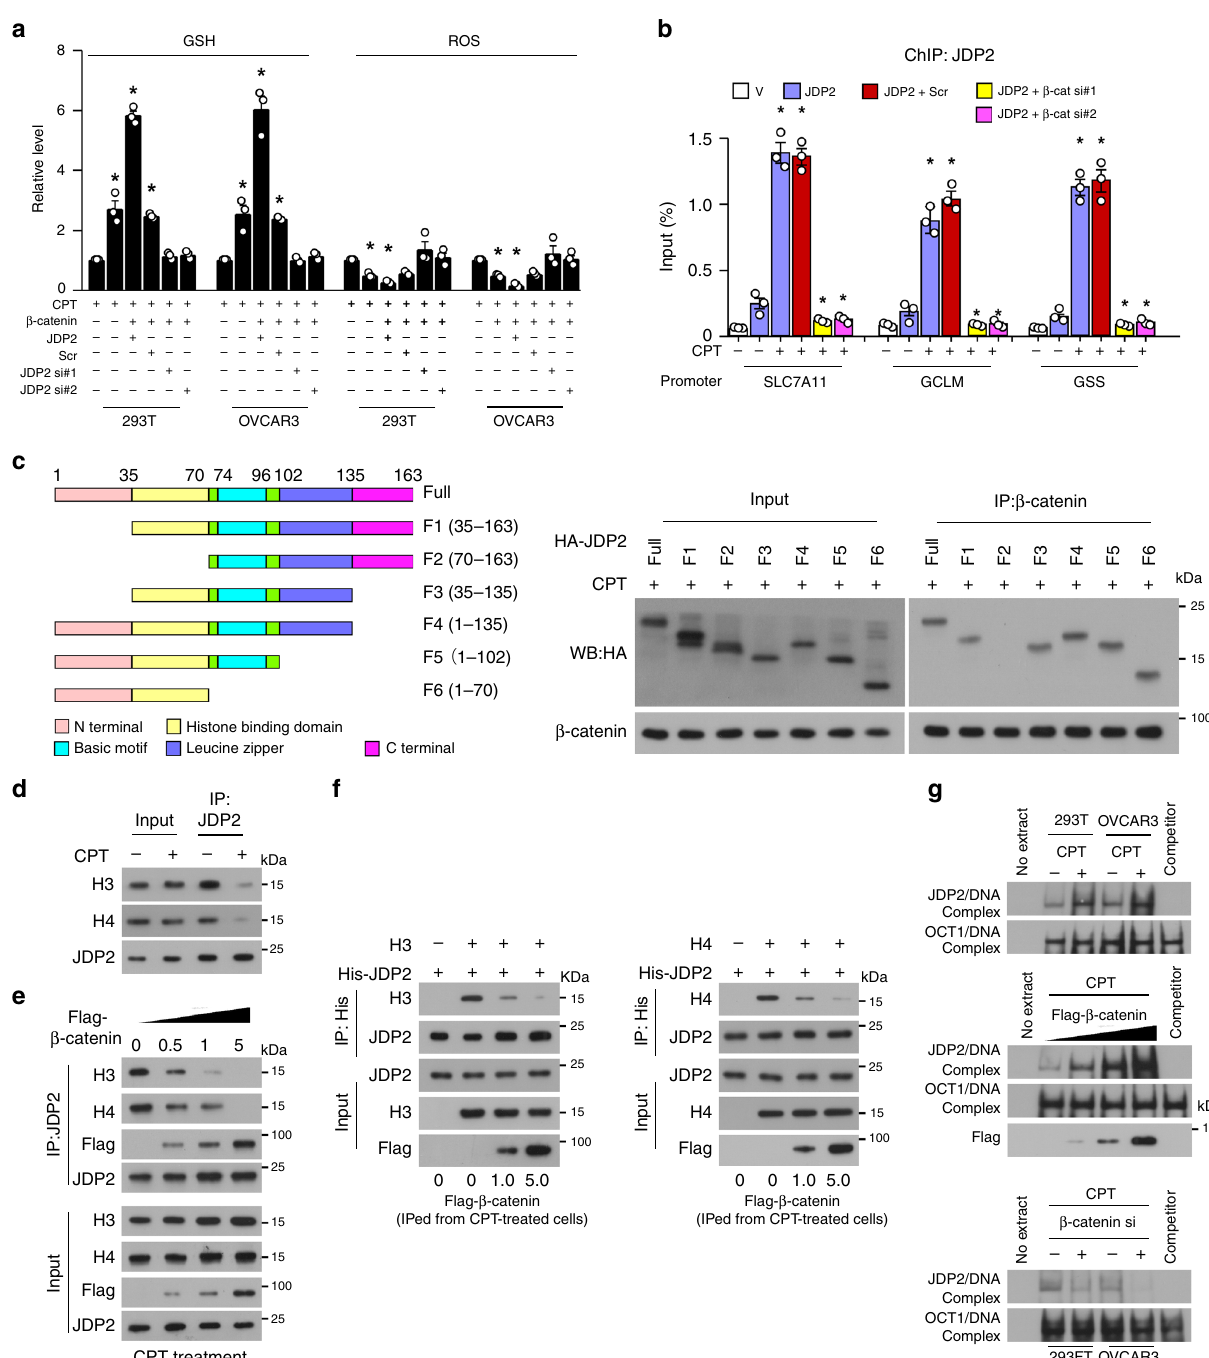
Fig. 4 β -catenin promotes the DNA-binding activity of JDP2 via inhibition of the JDP2/histone interaction. a Relative expression of GSH (left) and ROS (right) were examined in the indicated cells treated with CPT (10 μ M, 4 h). + : treatment, − : untreatment. b ChIP assay analysis of the enrichment of JDP2 on the promoters of SLC7A11 , GCLM , and GSS in the indicated cells treated with or without CPT (10 μ M, 1 h). c Schematic illustration of the wild-type and truncated JDP2 (left); co-IP assays were performed using anti- β -catenin antibody in the CPT (10 μ M, 1 h)-treated cells transfected with truncated JDP2 fragments (right). d IP assays were performed using anti-JDP2 antibody in the indicated cells treated with or without CPT (10 μ M, 1 h) and IB analysis of expression of JDP2, Histone 3, and Histone 4. e IP assays were performed using anti-JDP2 antibody in CPT (10 μ M, 1 h)-treated cells transfected with 0, 0.5, 1.0, and 5.0 μ g of a Flag-tagged β -catenin plasmid and IB analysis of expression of JDP2, Flag-tagged β -catenin, Histone 3, and Histone 4. f In vitro binding assays were performed using anti-His antibody in the reactions mixed with recombinant His-tagged JDP2, recombinant Histone 3 (left), or Histone 4 (right), and Flag antibody-immunoprecipitated lysates from CPT (10 μ M, 1 h)-treated cells transfected with 0, 1.0, and 5.0 μ g of a Flag-tagged β -catenin plasmid. g JDP2 DNA-binding activity analyzed using an EMSA assay were examined in the indicated cells treated with or without CPT (10 μ M, 1 h) (upper), or in CPT (10 μ M, 1 h)-treated cells transfected with 0, 1.0, and 5.0 μ g of a Flag-tagged β -catenin plasmid (middle), or in CPT (10 μ M, 1 h)-treated cells transfected with or without β -catenin siRNA (lower). OCT-1 served as the loading control. Each error bar in panels a and b represents the mean ± SD of three independent experiments. * P < 0.05. Student ’ s two-tailed t test. Source data of Fig. 4a and b are provided as a Source Data fi